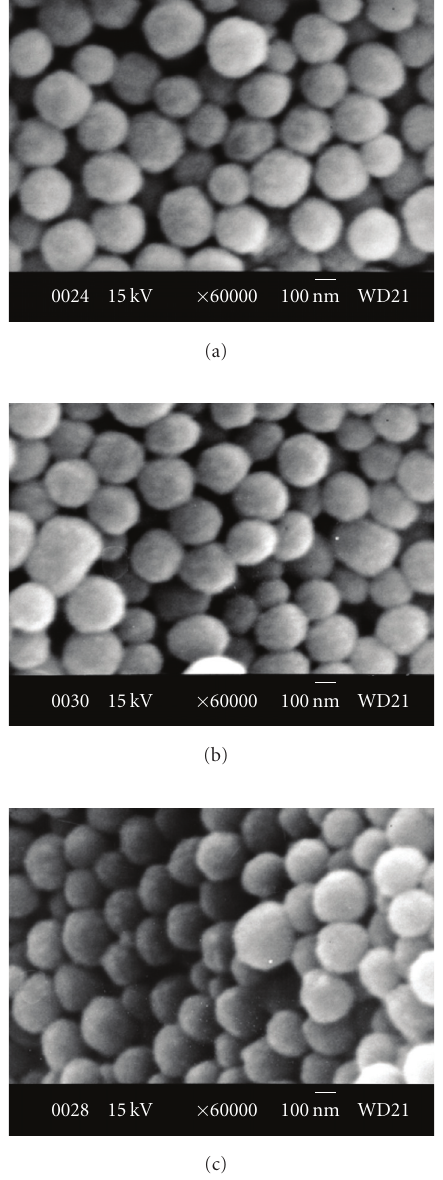
Figure 5: SEM images of squid melanin with heavy metals. (a) Natural squid melanin; (b) Cd(II)-enriched (105 mg/g); (c) Pb(II)- saturated (135mg/g). The scale bar in each panel corresponds to 100nm.